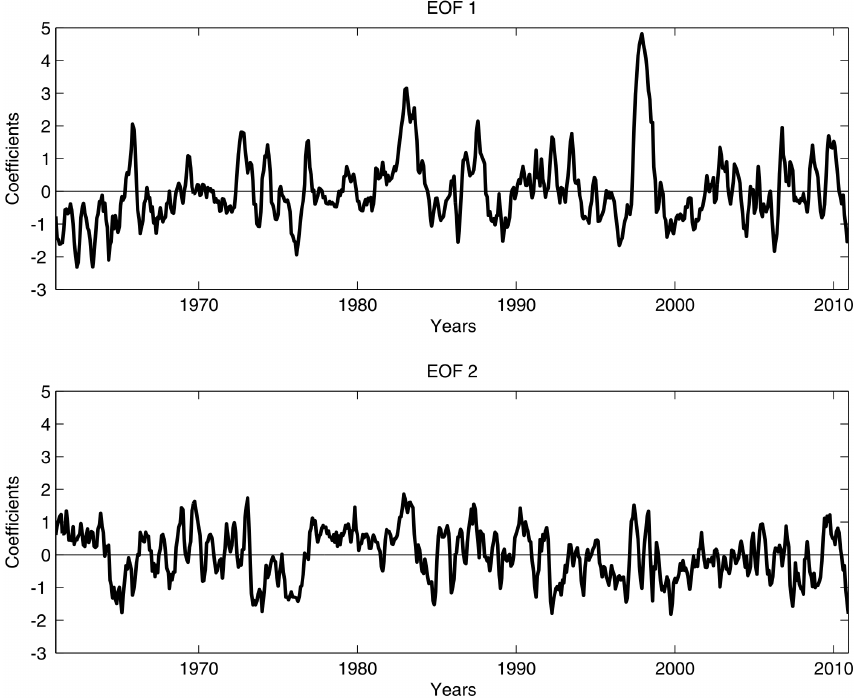
Fig. 2. Time series of EOF1 (top) and EOF2 (bottom) of the sea–air variables of Tumaco, Colombia.